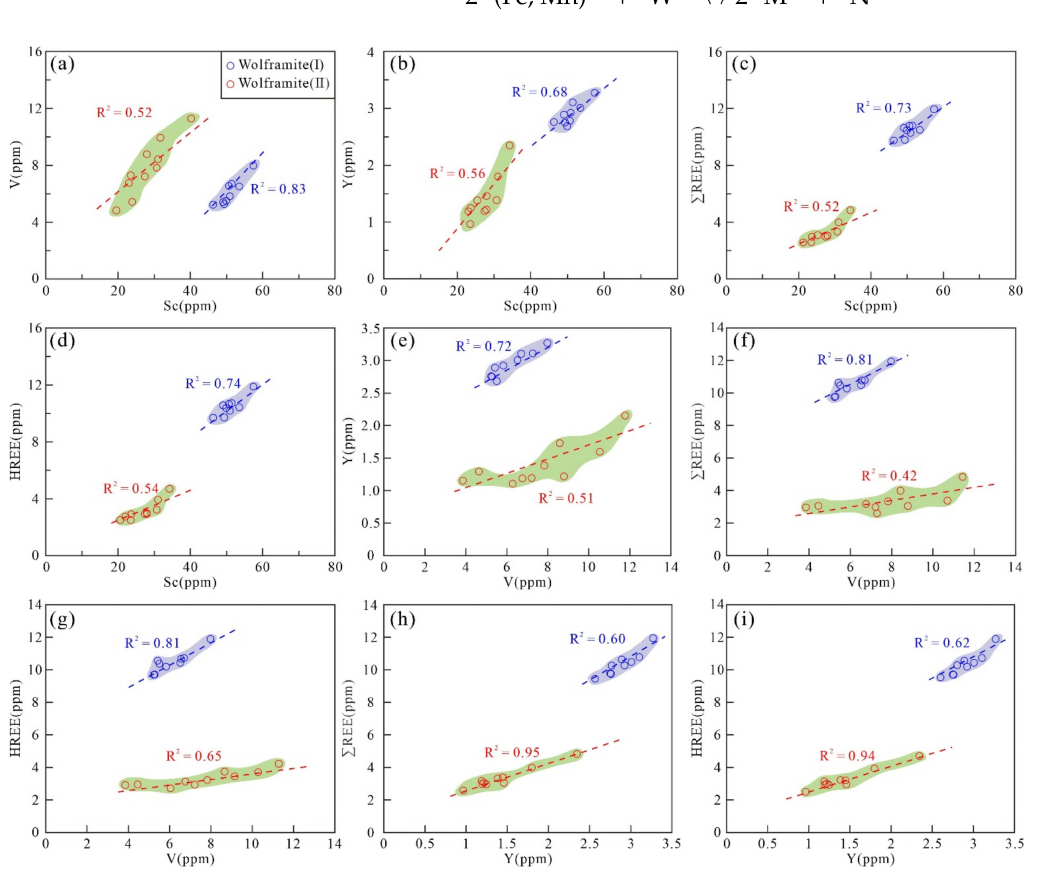
Figure 12. Trivalent cations correlation plots for two generations of wolframite from the Baishitouwa deposit. ( a ) Correlation plots of Sc and V contents; ( b ) Correlation plots of Sc and Y contents; ( c ) Correlation plots of Sc and ∑ REE contents; ( d ) Correlation plots of Sc and HREE contents; ( e ) Correlation plots of V and Y contents; ( f ) Correlation plots of V and ∑ REE contents; ( g ) Correlation plots of V and HREE contents; ( h ) Correlation plots of Y and ∑ REE contents; ( i ) Correlation plots of Y and HREE